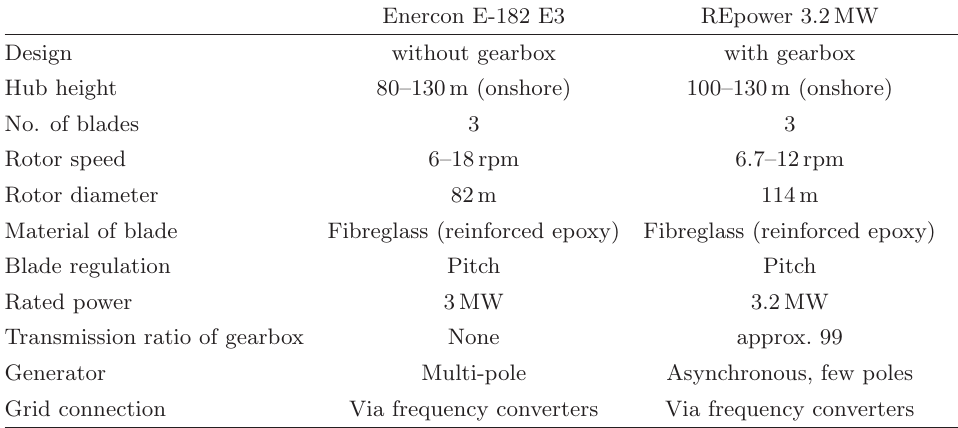
Table I. – The technical features of two different multi-megawatt wind turbines for